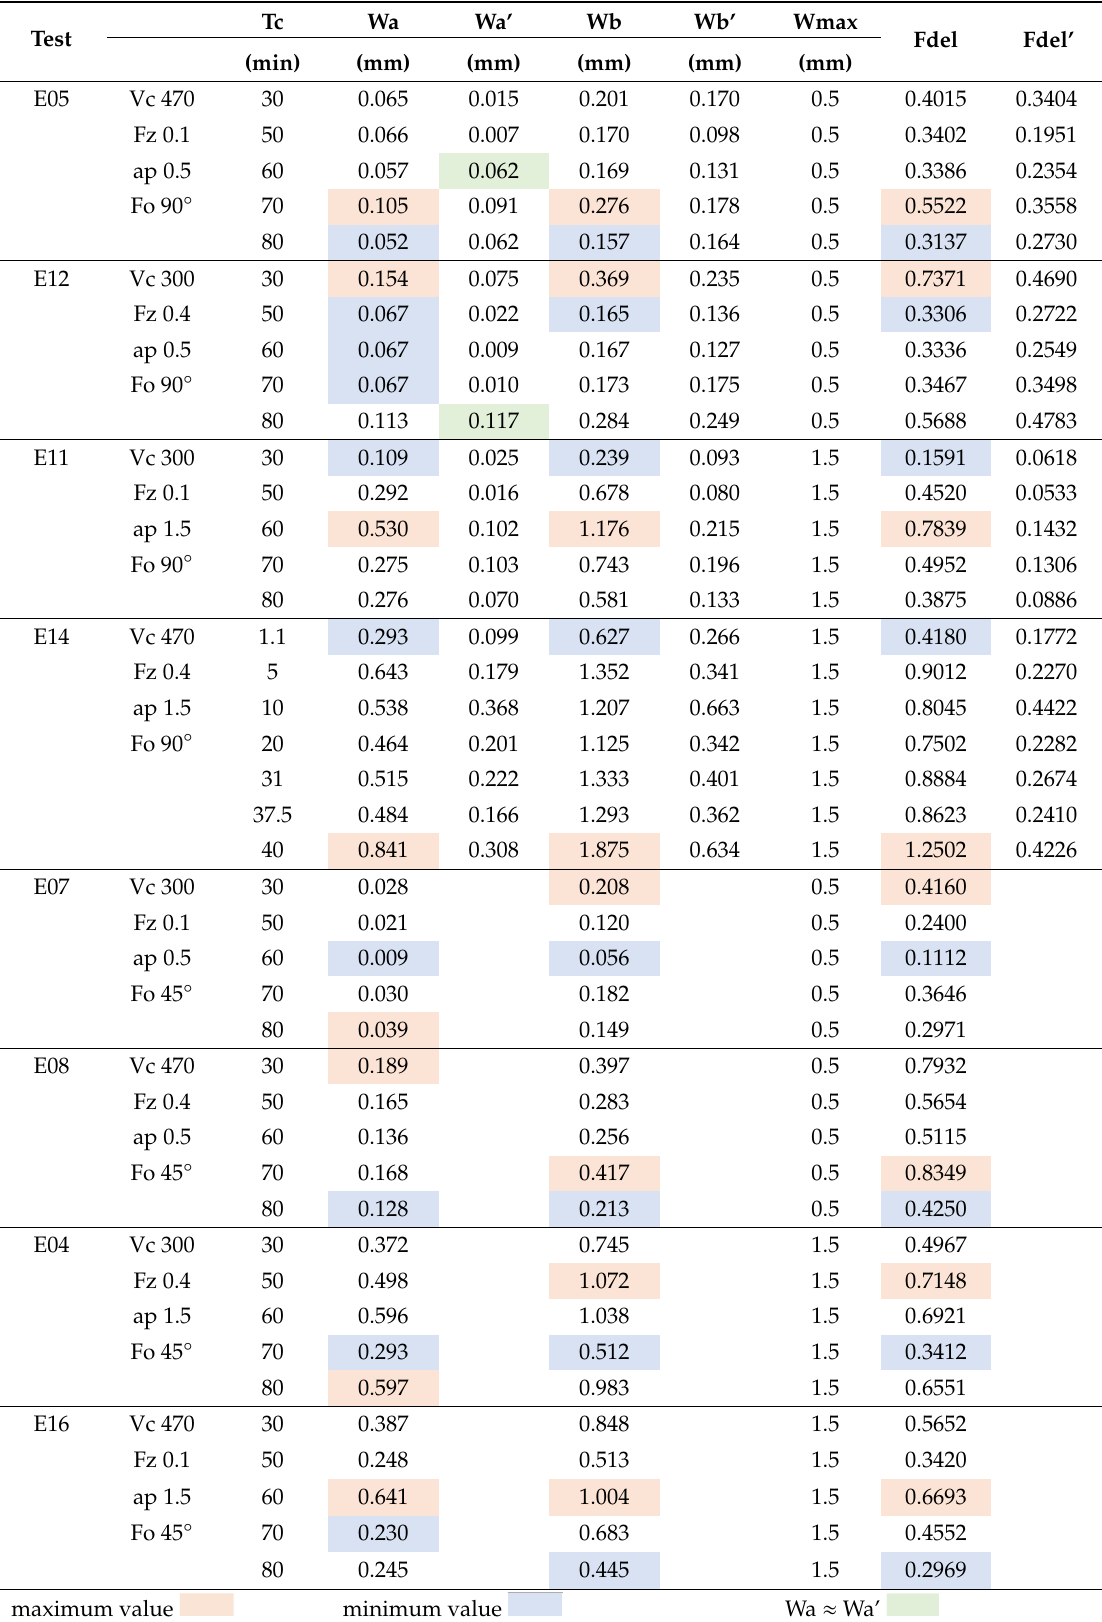
Table 5. Parameter values in Type II